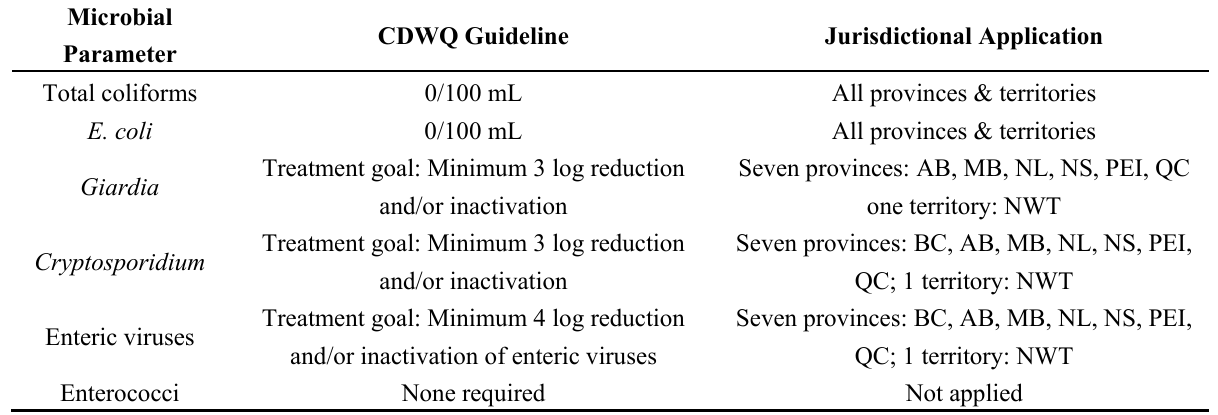
Table 4. Microbial drinking water quality